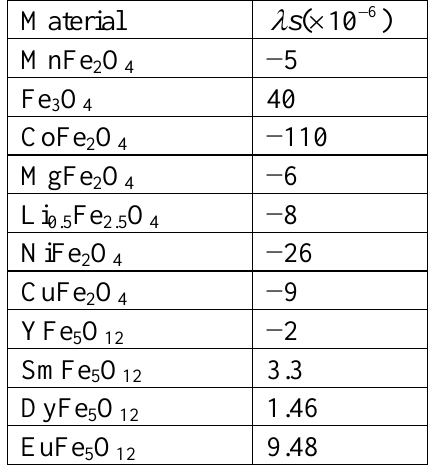
Table 6. Magnetostrictions for ferrite